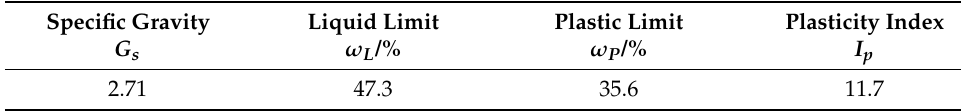
Table 3. Main chemical composition of red mud. Table 2. Basic physical properties of red mud.